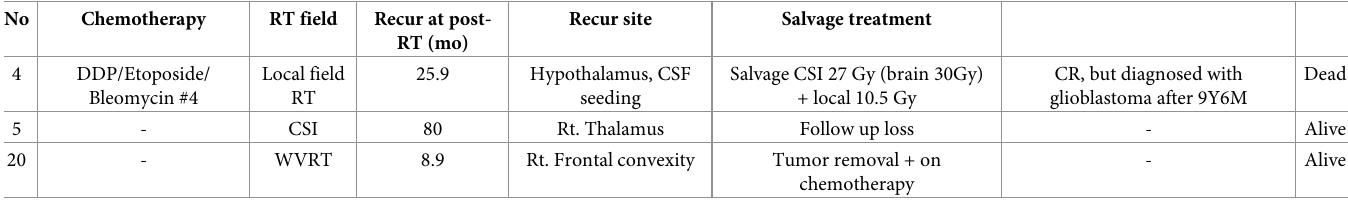
Table 4. Recurrence characteristics and salvage treatment of patients with recurrence. Treatment and recurrence characteristics, salvage treatment and survival of patients with recurrence.